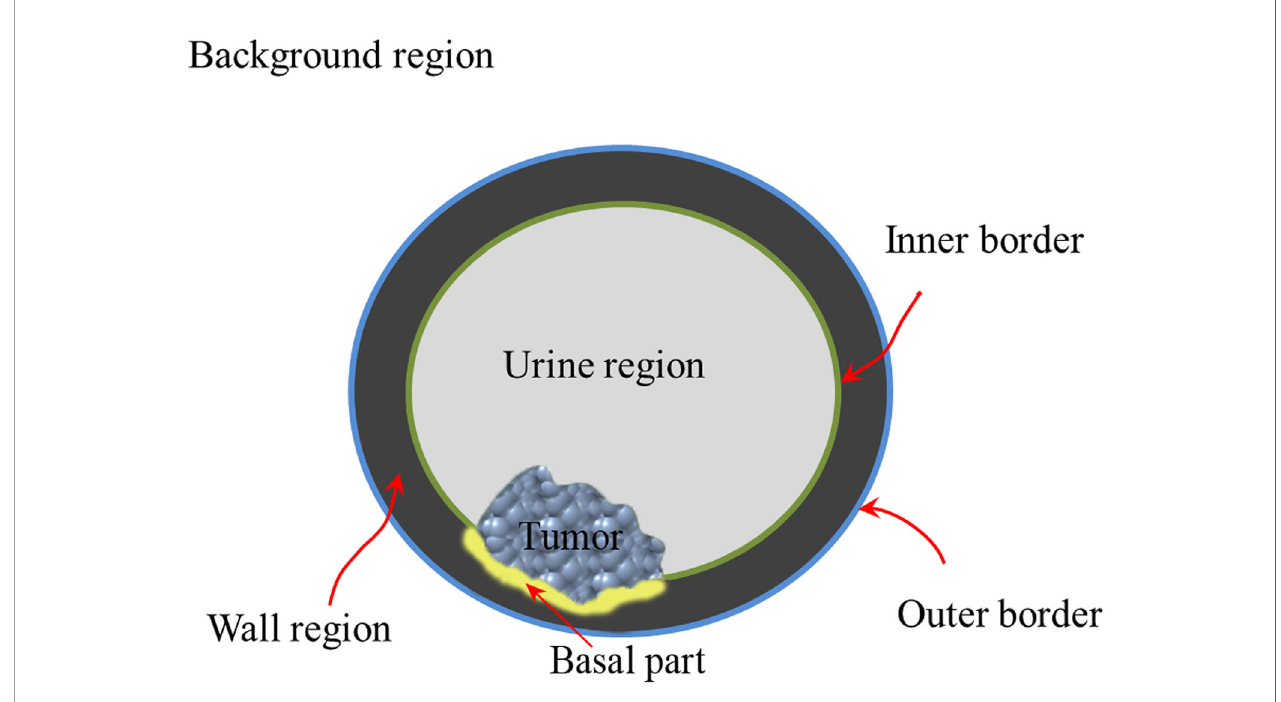
FIGURE 3 | Structure diagram of the multiregion of bladder on the noninvasive